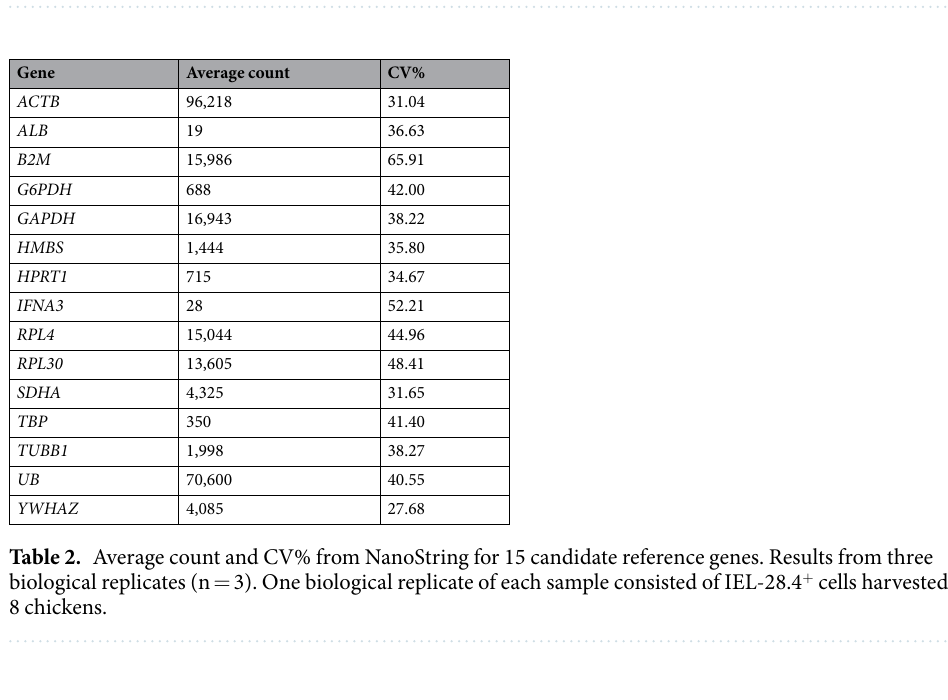
Table 1. Total IEL cells, percentage of IEL-28.4 + cells and total no of IEL-28.4 + cells. Results from three biological replicates (n = 3). One biological replicate of each sample consisted of IEL cells or IEL-28.4 + cells harvested from 8 chickens. Percentage of IEL-28.4 + cell population was quantified by flow cytometry while total number of IEL cells was counted post-harvesting of IEL cells. * indicates significant between different samples using one-way ANOVA (p < 0.05). The value was the means ± SEM of three experiments.